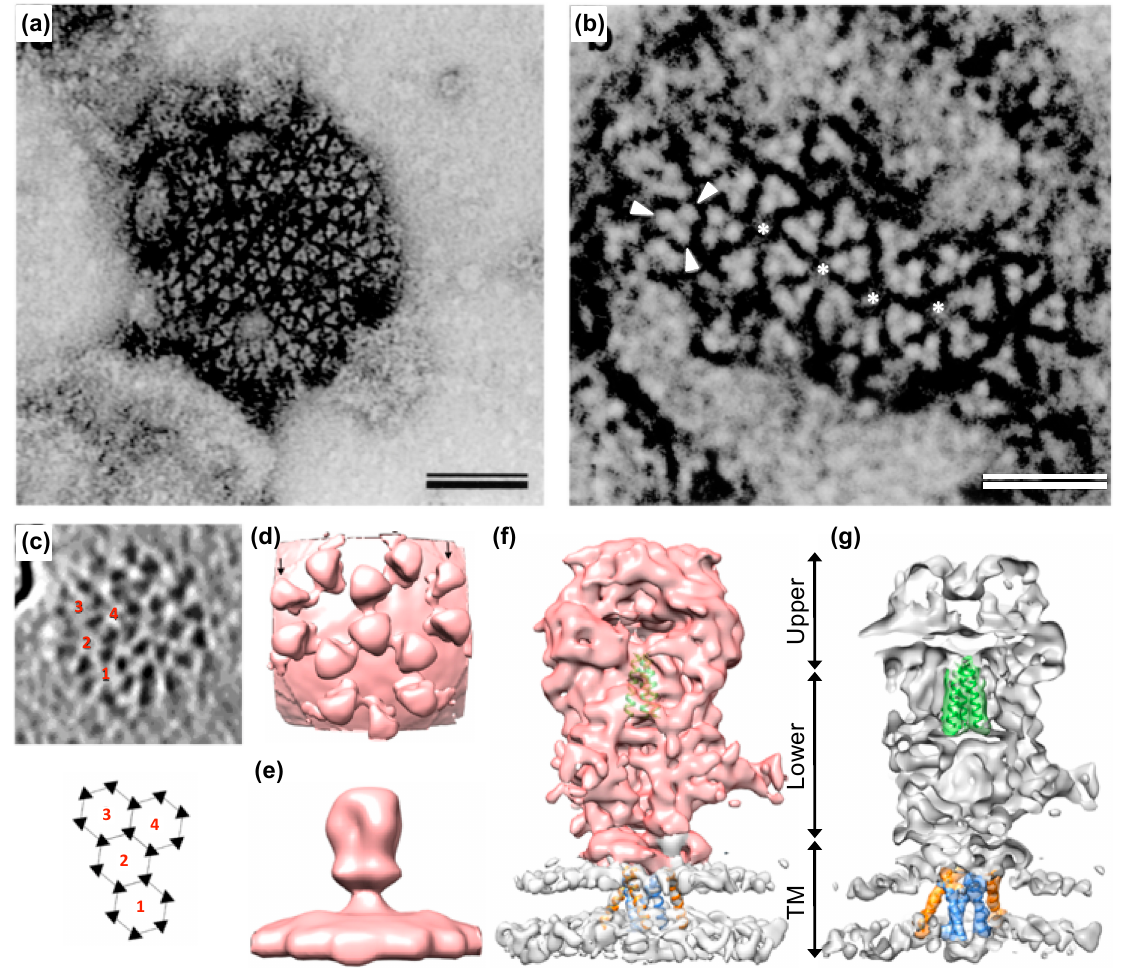
Figure 4. Structure of FV envelope glycoprotein complex (GPC) and the GPC lattice of FV virions. ( a ) Surface features of PFV particles detected by negative-staining EM. Virions show a network of trimeric viral spike proteins on the particle surface and are predominantly arranged into rings of six subunits. Adjacent rings always share two completely integrated spikes. Images at higher magnification ( b ) reveal three separate densities (arrowheads) in the triangular spike. When grouped in hexameric rings, a stain-filled hole with a diameter of about 8 nm was formed (asterisk). Bars represent 50 nm ( a ) and 25 nm ( b ); ( c – e ) subtomogram averaging of PFV glycoprotein. ( c ) 0.8 nm thick tomographic slice perpendicular to the glycoprotein long axis and its corresponding schematic of interlocked hexagonal assemblies of trimers. Numbers are indicated at the center of each hexagon and triangles represent the position of each trimer of Env in the hexagonal network. ( d ) Top view of intertwined hexagonal assemblies. ( e ) Side view of a single trimer. ( f – g ) In Situ single particle 3D reconstruction of PFV glycoprotein by cryo-EM. Full ( f ) and cut-away ( g ) side views of a single PFV Env trimer (sharpened map) after 3-fold symmetry application (~9 A resolution at FSC = 0.143). The densities corresponding to the extracellular domains and the viral membrane are colored salmon and gray respectively in ( f ). The three central helices attributed to gp48 fusion peptide are represented by three green α helices of 22 residues long each. The transmembrane helices (TMHs) are represented by three inner (colored blue) and three outer (colored orange) α helices. In ( g ), the densities surrounding the three central helices and the three inner and outer TMHs are colored green, blue and orange respectively while the remaining of the spike is gray colored. Panel a and b adapted from [95]; panel c – g adapted from [7].